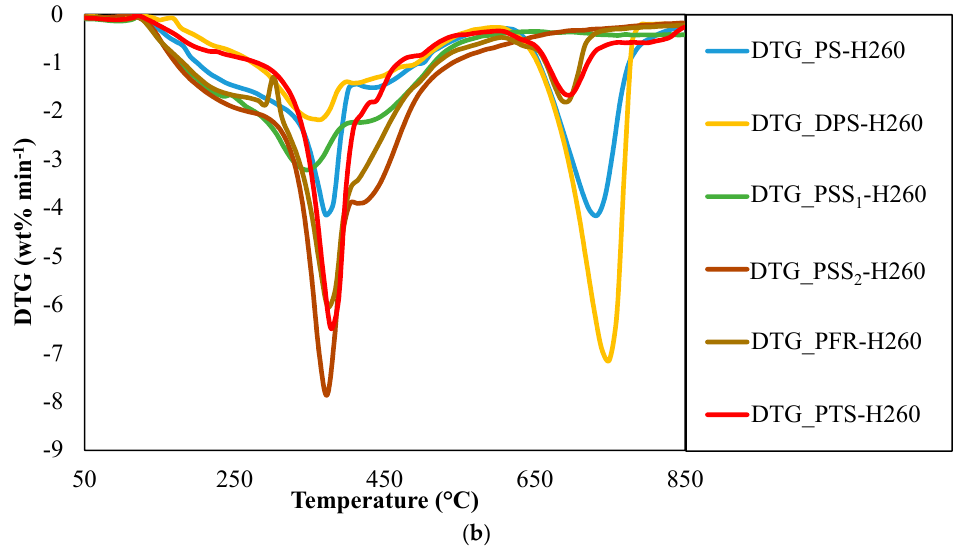
Figure 2. Pyrolysis thermograph plotted versus temperature ( a ) and derivative thermal gravimetric (DTG) curves plotted versus temperature ( b ) for all 260 °C hydrothermal carbonization (HTC) treated paper mill sludges (PMS).